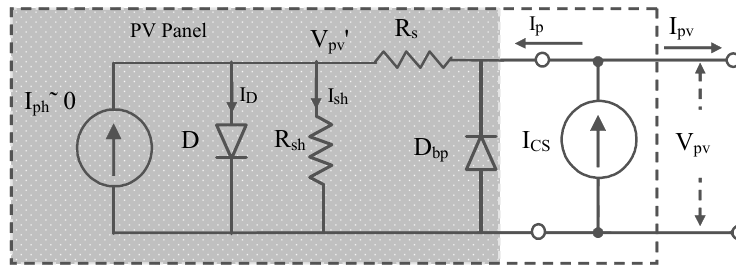
Figure 12. Equivalent circuit of the emulated PV source.